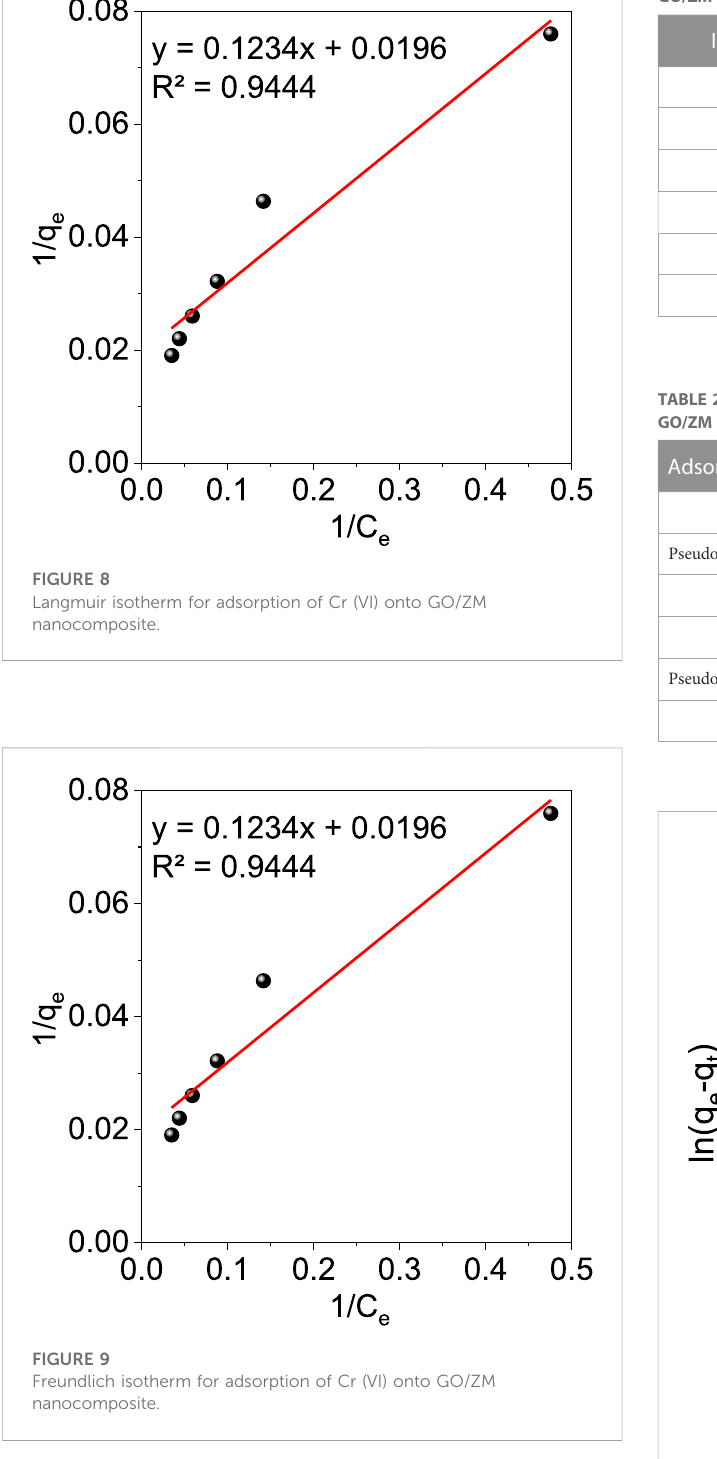
FIGURE 10 Pseudo fi rst order kinetic model for adsorption of Cr (VI) onto GO/ ZM